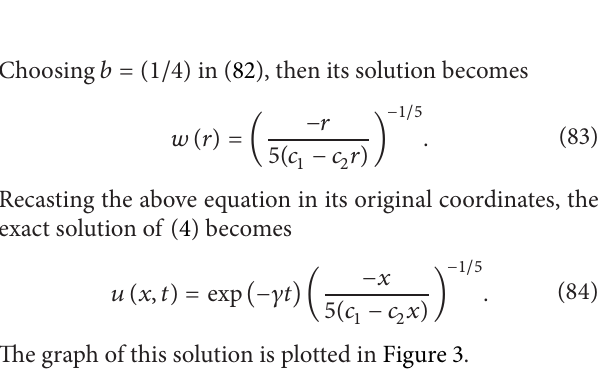
Figure 3: Plot of solution (84) with 𝑏 = 1/4 , 𝛾 = 𝑐 1 = 𝑐 2 = 1